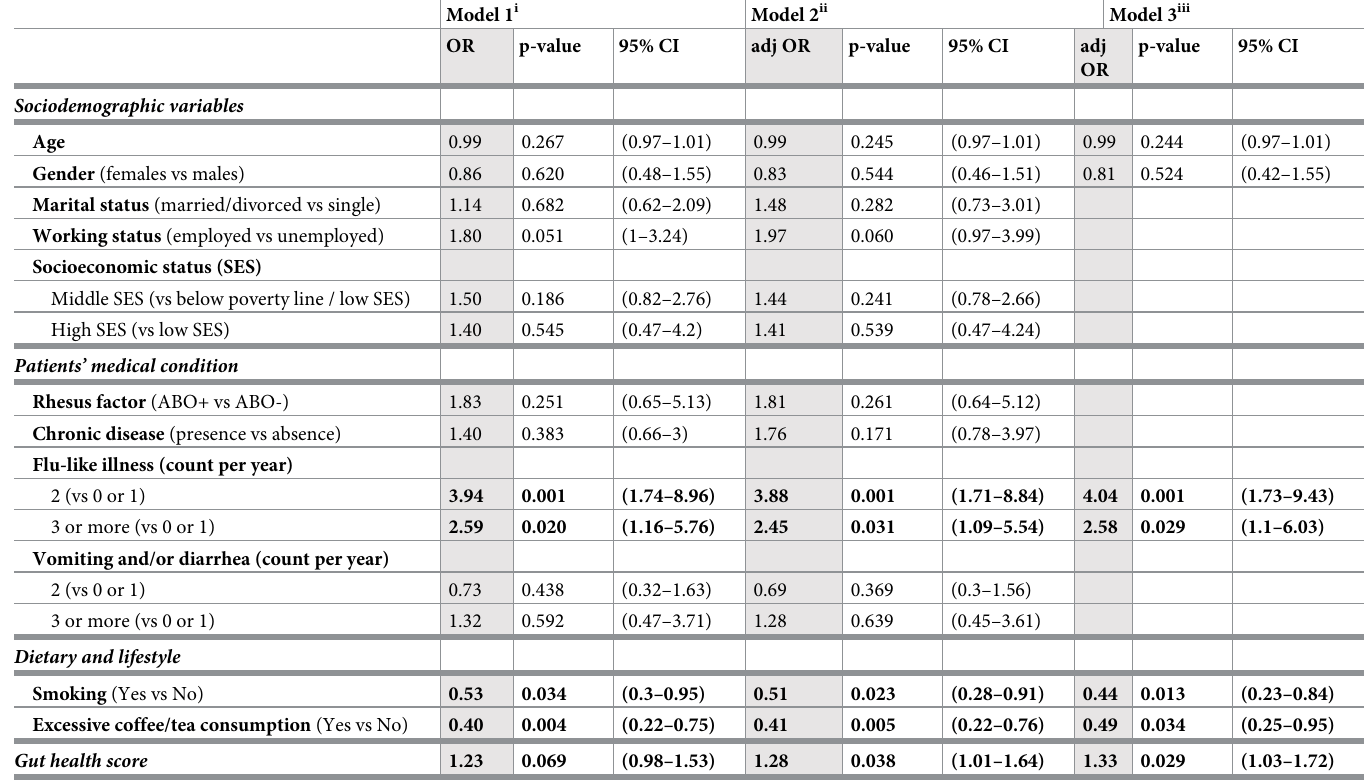
Table 6. Determinants of having any COVID-19 symptoms (vs none) using simple and multiple logistic